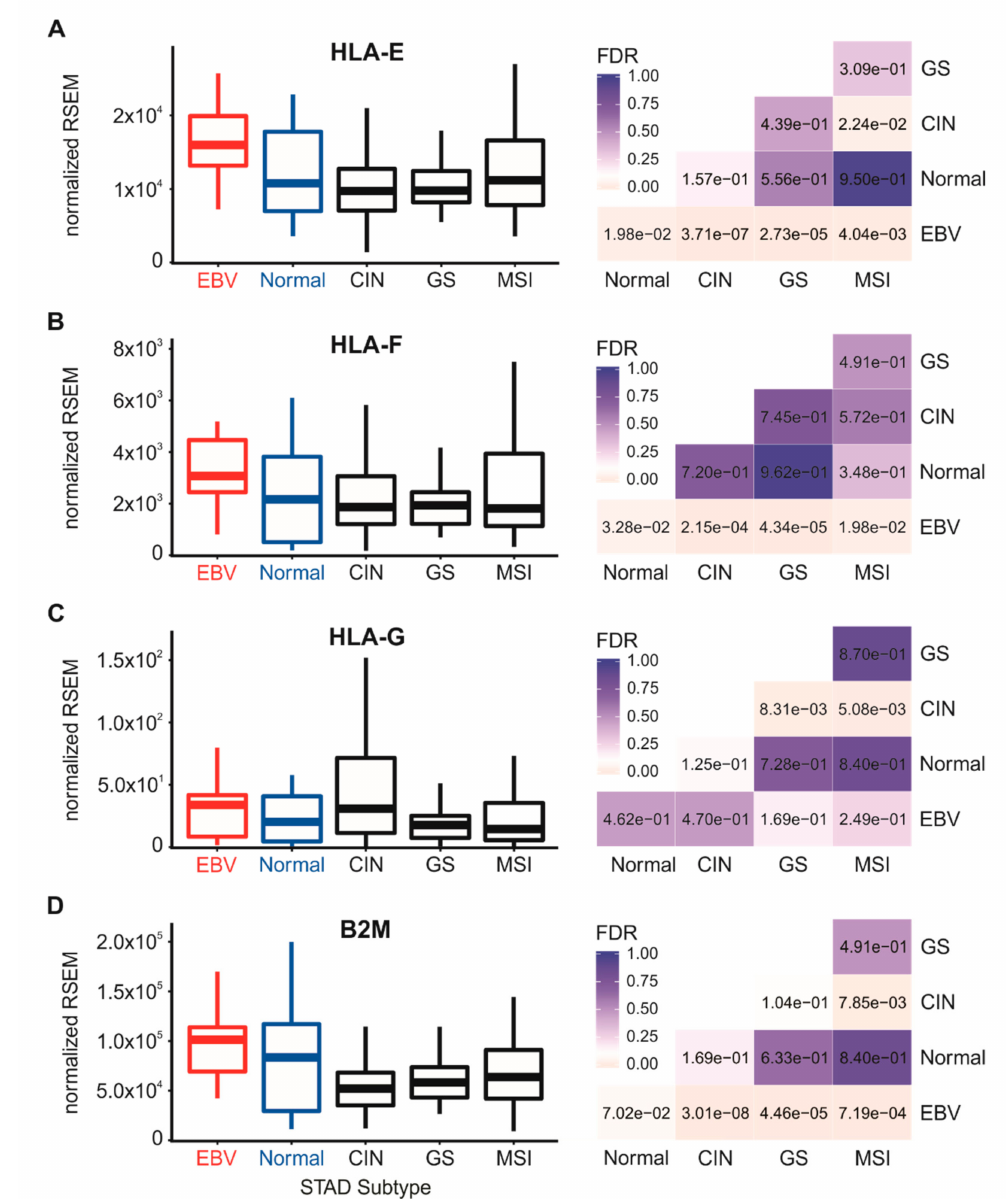
Figure 2. Expression of non-classical MHC-I heavy chain genes and light chain in gastric carcinoma subtypes and normal gastric tissue. Normalized RNA-seq data for the HLA-E ( A ), HLA-F ( B ) and HLA-G ( C ) MHC-I heavy chain and B2M ( D ) light chain genes were extracted from the TCGA database for the STAD cohort for EBVaGCs, normal control tissues, and three other GC subtypes. FDR-adjusted p -values for each statistical comparison are shown on the right for each gene